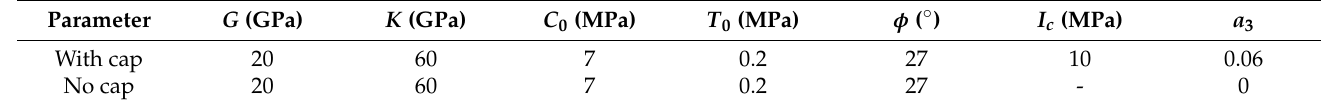
Figure 3. ( a ) A cylindrical opening under far ‐ field isotropic stresses outside and an internal pressure applied to the inside wall, ( b ) a numerical model built with FLAC3D after taking advantage of the symmetry along two axes. Table 1. Parameters used for comparing the results obtained with the FLAC3D MSDP u -EPP model and analytical solutions (taken from Li and Aubertin